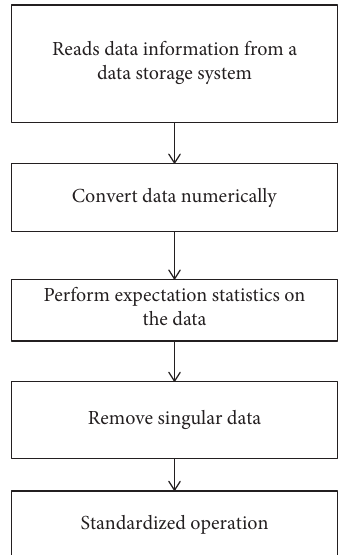
Figure 3: Flow chart of data cleaning process.